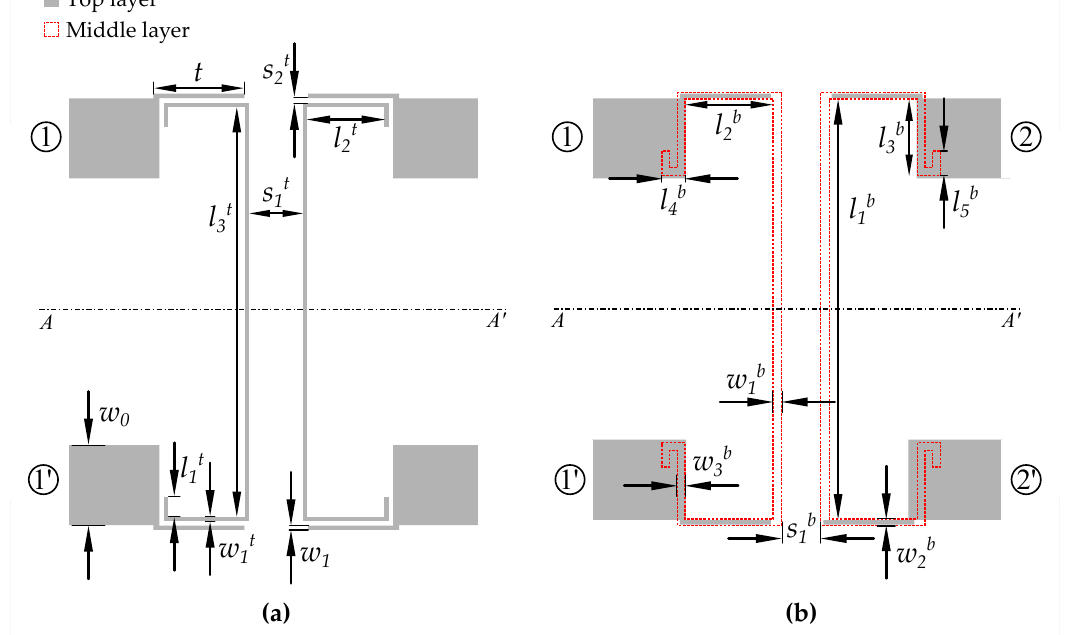
Figure 2. 2-D view of the two printed planes of the structure (not to scale). ( a ) Top layer; ( b ) Middle